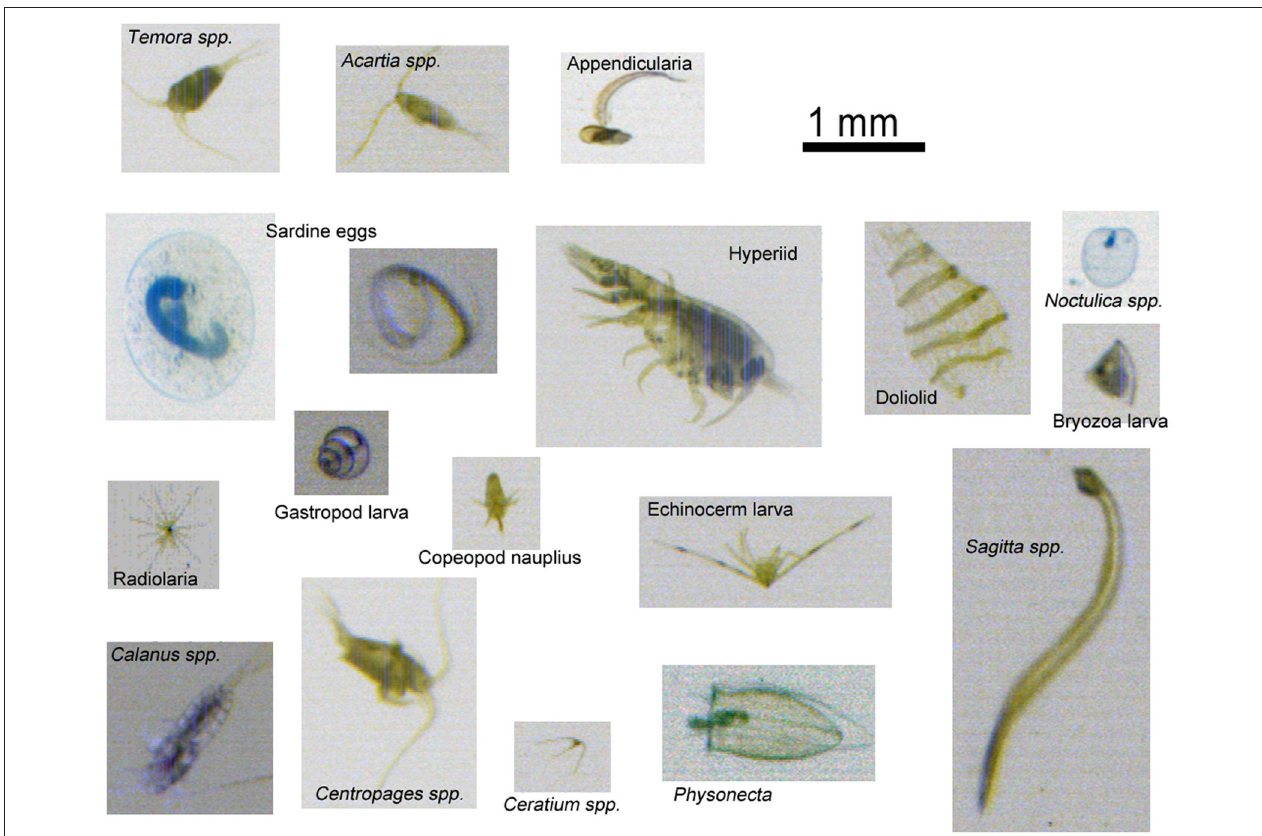
FIGURE 3 | Images of plankton taken using the PIA during the survey. Particles imaged in the water flow are sized prior to storage, with particles smaller than 240 µ m being rejected.